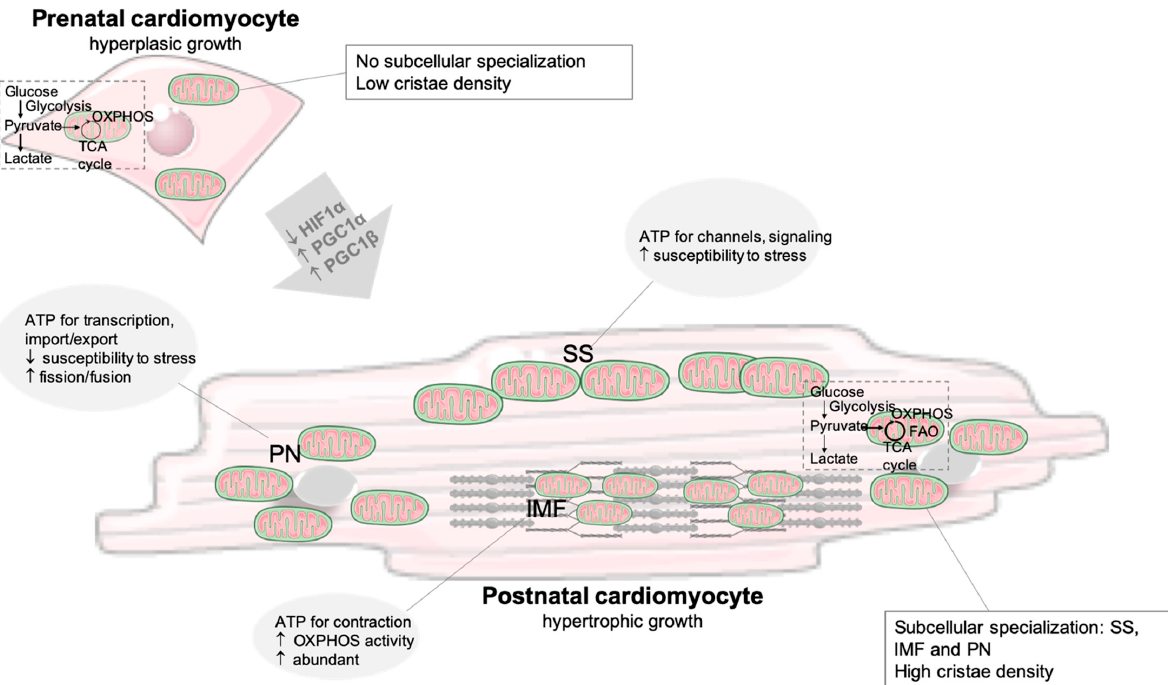
Figure 1. Connection between cardiomyocyte development and mitochondria usage and maturation, highlighting mitochondria specialization according to the spacial arrangement in postnatal cardiomyocytes. After birth, a bioenergetic shift from glucose-driven anaerobic glycolysis to the oxidation of fuels in the mitochondria occurs. Mitochondria increase in size and density, and cristae become denser. The upregulation of PGC coactivators and the downregulation of HIF1 α regulate mitochondria biogenesis. Abbreviations: FAO, fatty acid oxidation; HIF, hypoxia-inducible factor; IMF, intermyofibrillar; OXPHOS, oxidative phosphorylation; PGC, peroxisome proliferator-activated receptor-gamma coactivator; PN, perinuclear mitochondria; SS, subsarcolemmal; TCA, tricarboxylic acid cycle; up arrow: increase; low arrow: